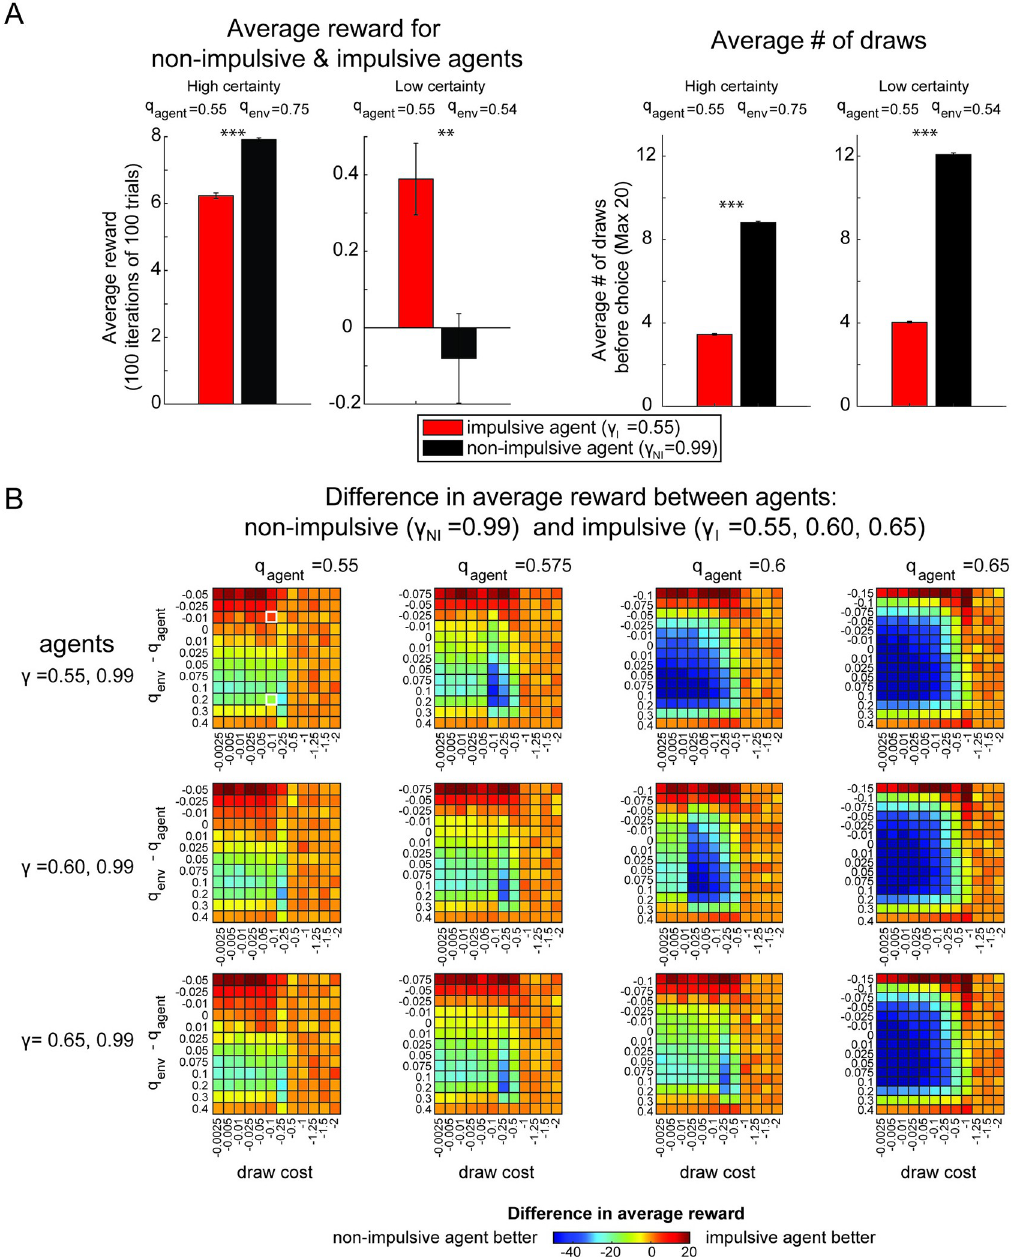
Fig 4. Performance and choice behavior of impulsive vs. non-impulsive agents in the Information Sampling (Beads) Task. A) Left: Average reward collected across simulated trials in certain and uncertain task environments for impulsive and non- impulsive agents in the Beads task. The non-impulsive agent (black) has a discount factor of γ = 0.99 and the impulsive agent (red) has a discount factor of γ = 0.55. Error bars are s.e.m. across 100 iterations of 100 trials using bead sequences from two different task parameters (q env = 0.75 certain environment, q env = 0.54 uncertain environment, q agent = 0.55. C draw = 0.1). Right: Average number of bead draws before guessing a color for each model in each task environment. In both task environments, the impulsive agent (red) draws similarly often, but significantly less than the non-impulsive agent (black). ��� indicates p < 0.0001 �� indicates p < 0.001. B) Model performance across a range of parameter values. Each panel is a heatmap showing the differences in average reward for a pair of non-impulsive and impulsive agents, indicated by the discount factors on the far left. Each column has a set of heatmaps for the expected majority fraction of beads, q agent . Each row has a set of heatmaps for a pair of discount factors (impulsive & non-impulsive). The x-axis of each heatmap is the draw cost and the y-axis is the difference between the model input q agent and the majority fraction used to generate the bead draws, q env . The color of the heatmap indicates whether the impulsive agent (red) or non-impulsive agent (black) collected more reward. More blue values